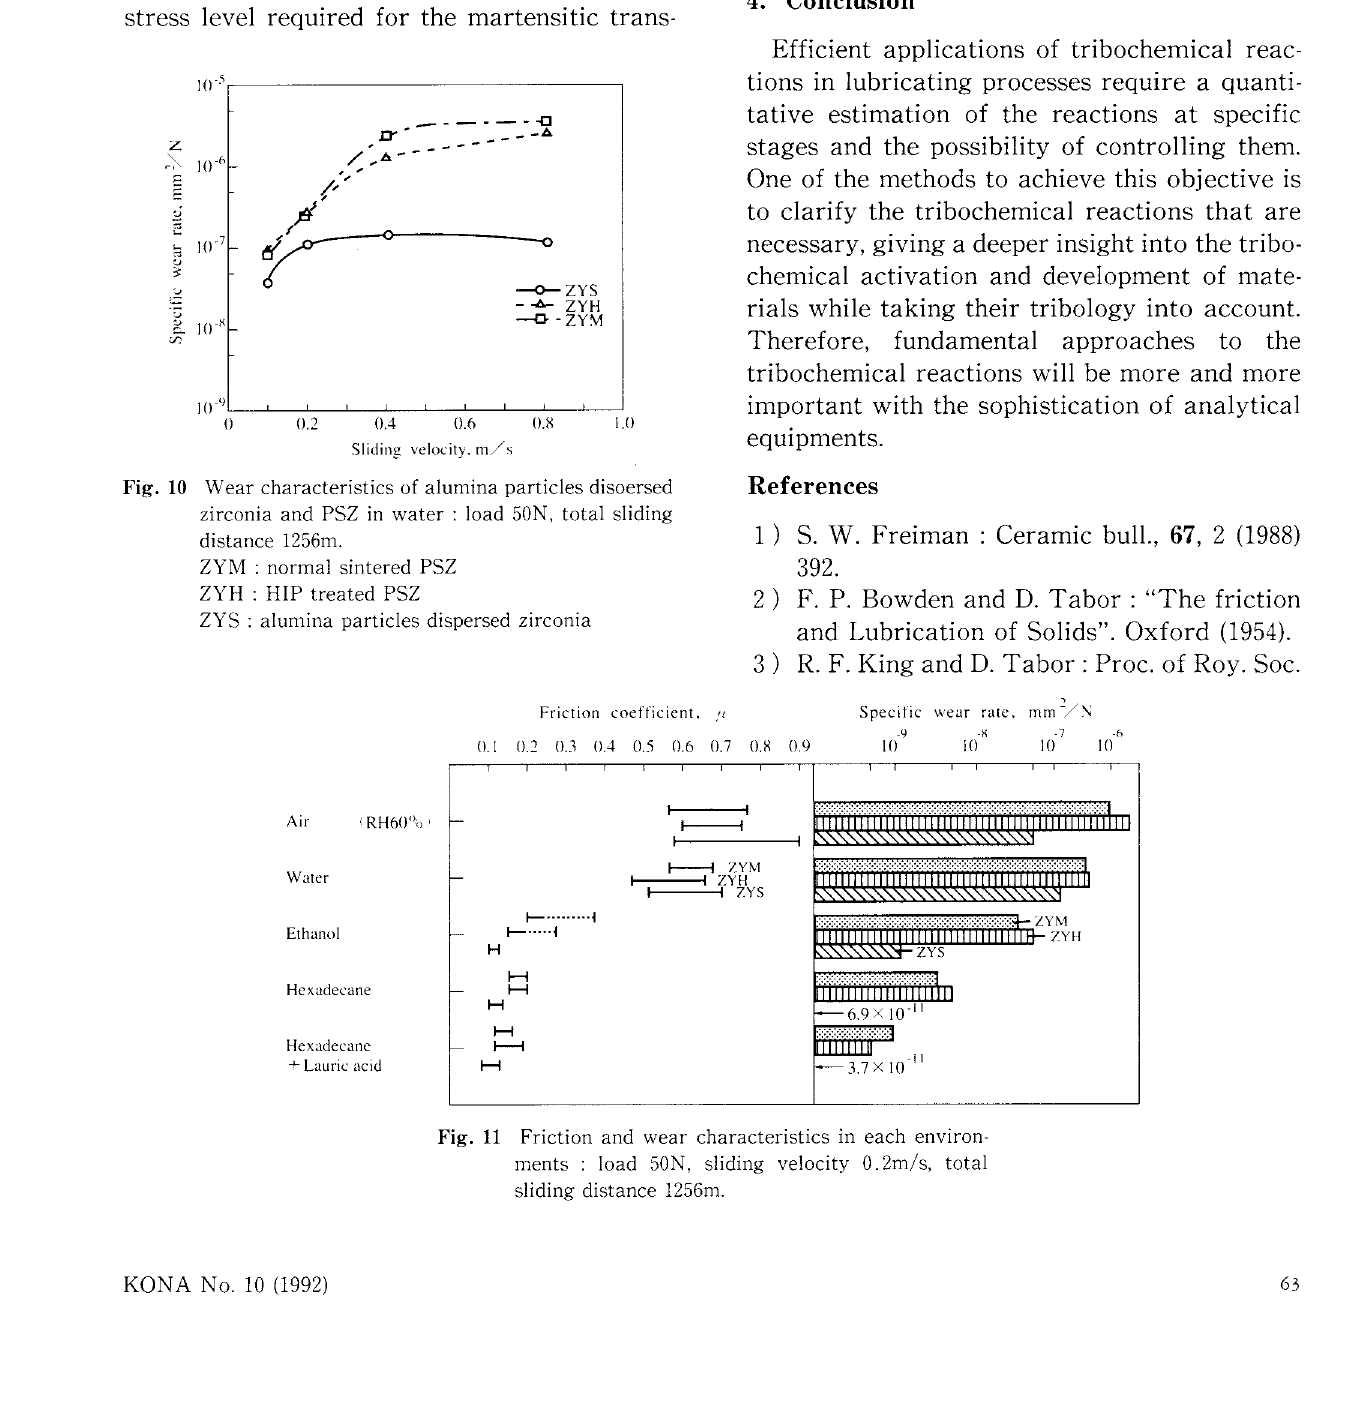
Fig. 11 Friction and wear characteristics in each environ· ments : load 50N, sliding velocity 0.2m/s, total sliding distance 1256m.